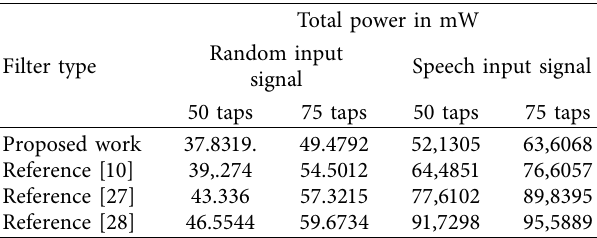
Table 3: Comparison of total power conception of the conven- tional and proposed FIR filters.